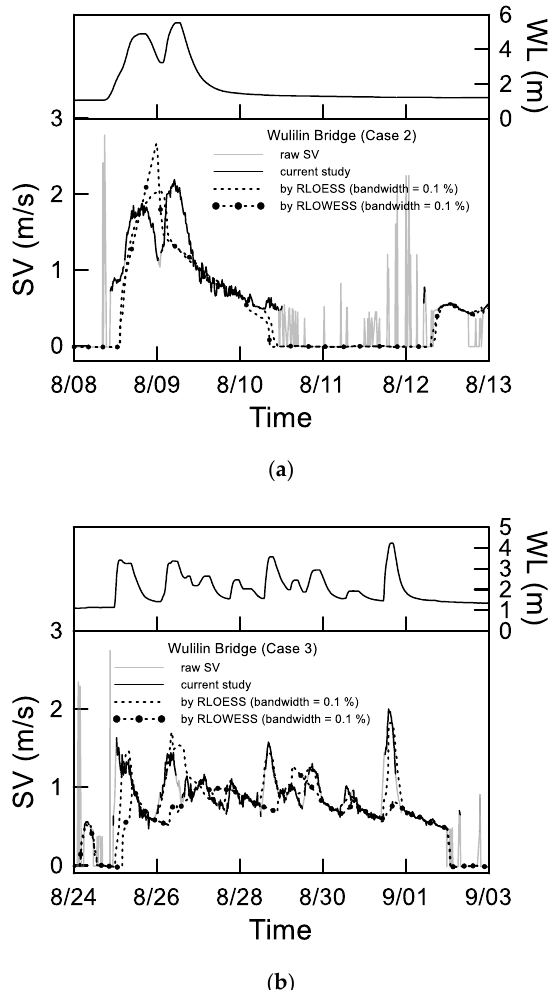
Figure 14. Local comparison of filtered SV data with smoothing methods at Wulilin Bridge: ( a ) Case 2; ( b ) Case3.